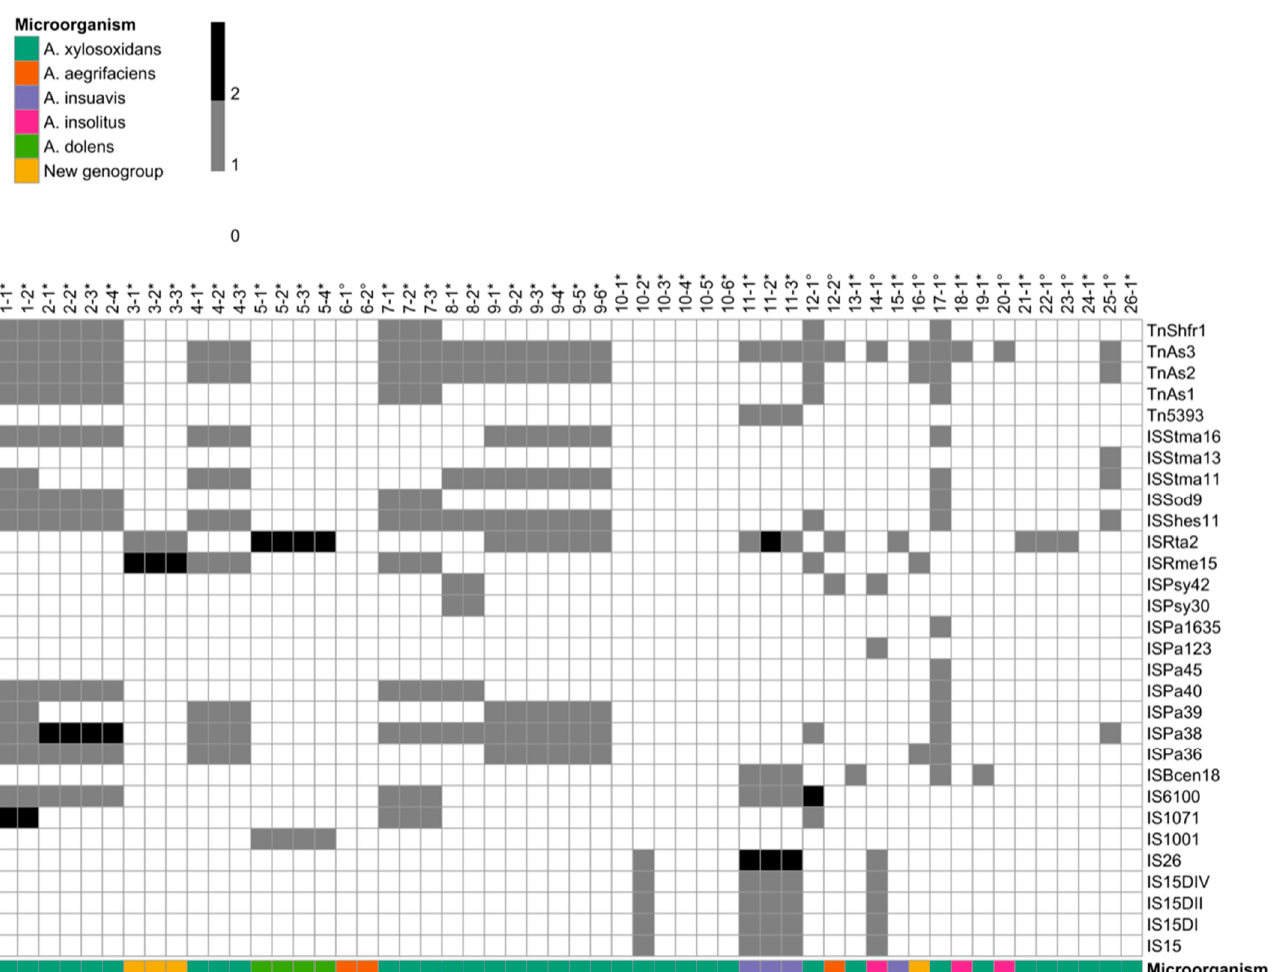
Figure 2. Insertion sequences (ISs) analysis. The heatmap shows the presence and number (grey scale) of ISs. The columns represent patients and isolates identification numbers. * indicates chronic infection isolates; ◦ indicates occasional infection isolates. Additional information regarding the microorganism species is represented in the annotation row (color scale) at the bottom.